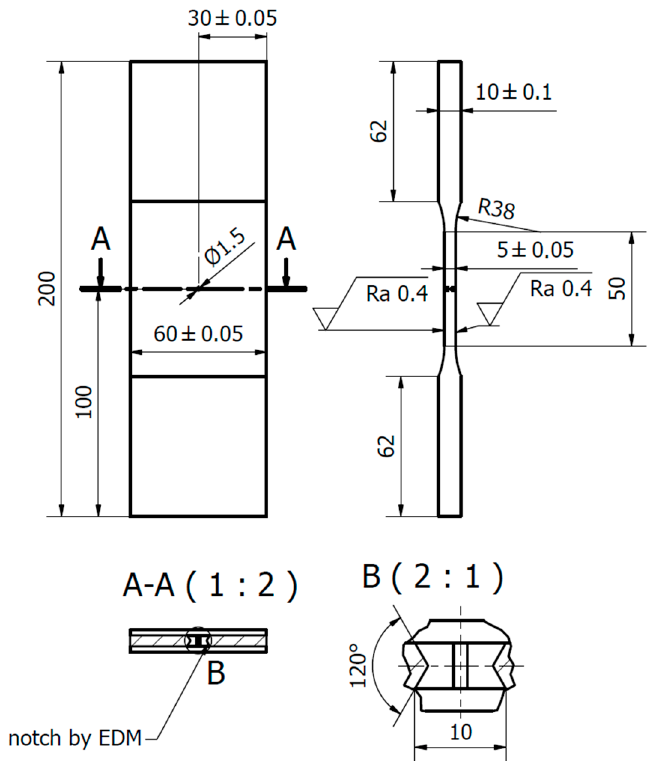
Figure 6. Scheme of the MT specimen used for experimental determination of the underload effects in the EA4T steel. (Unit: mm)